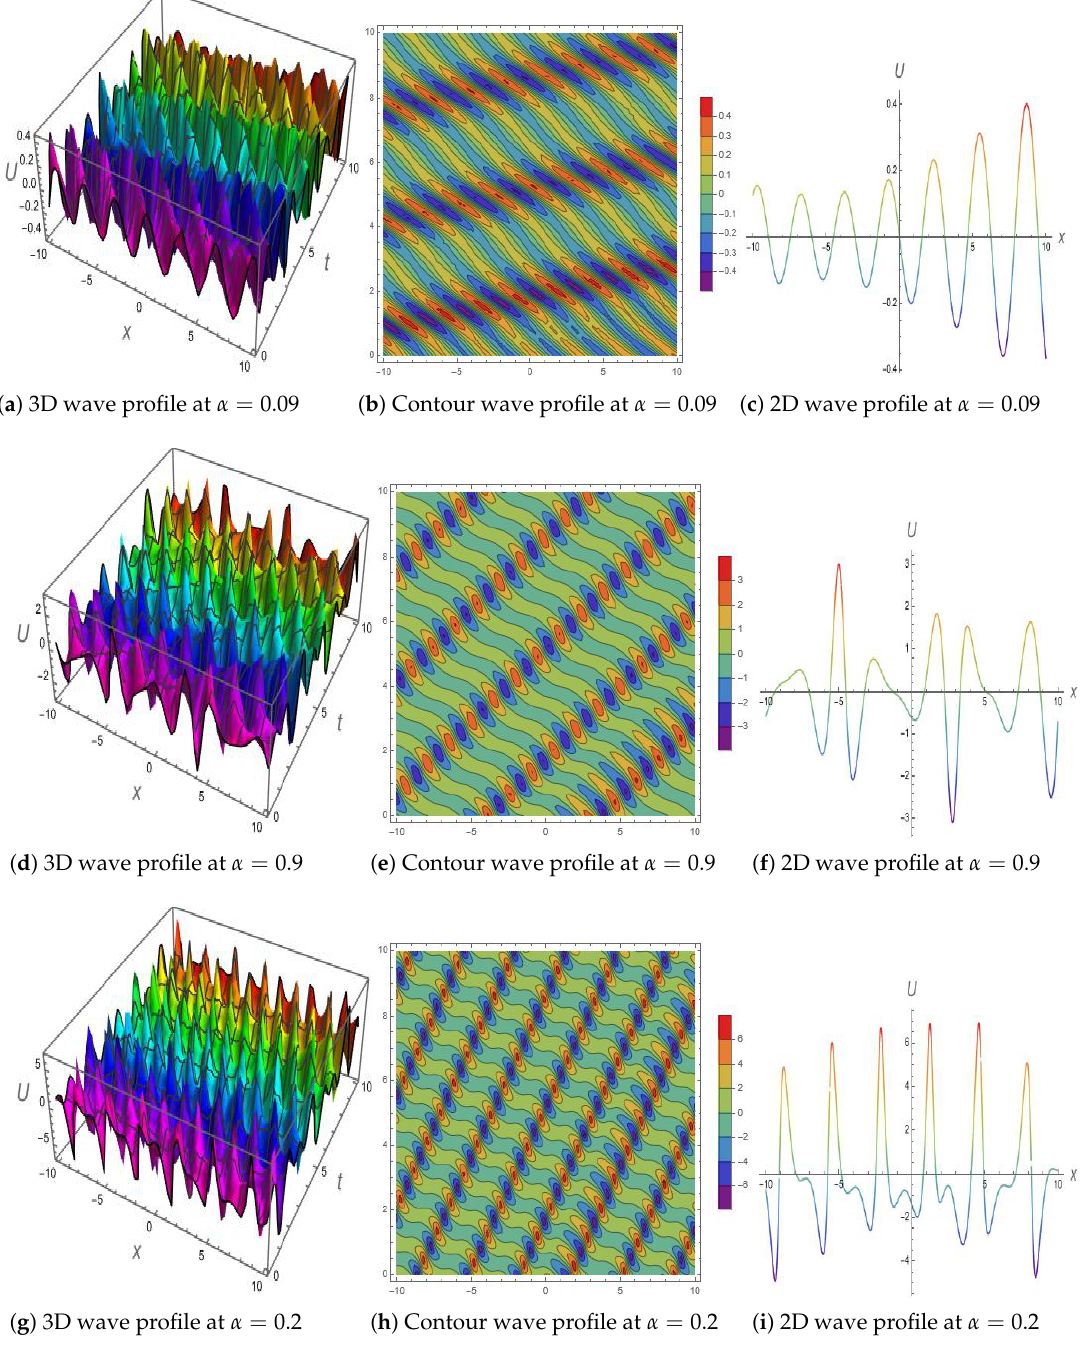
Figure 3. 3D, Contour and 2D impact of wave number α on the Imaginary part of solution U 3